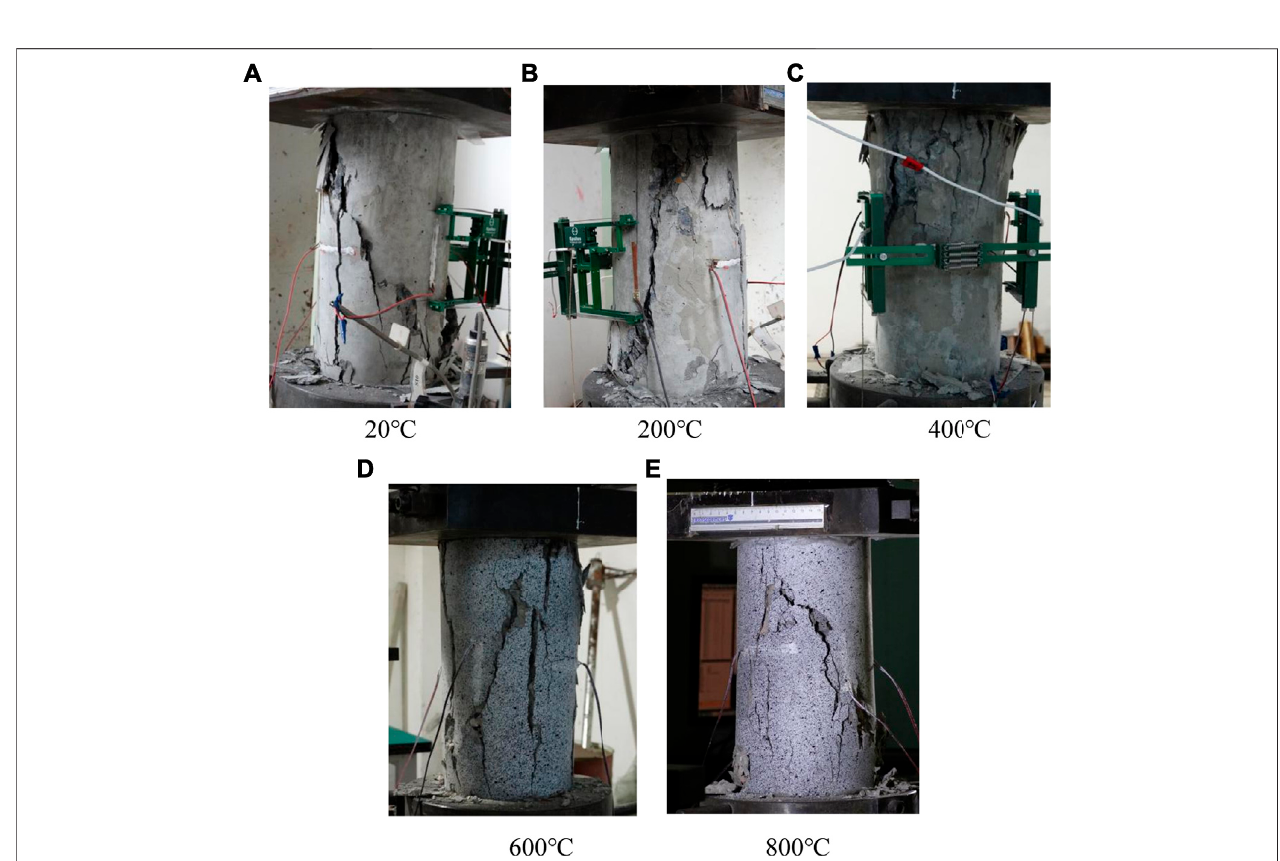
FIGURE 2 | Failure modes of uncon fi ned heat-damaged concrete cylinders. (A) 20 ° C, (B) 200 ° C, (C) 400 ° C, (D) 600 ° C, (E) 800 ° C.